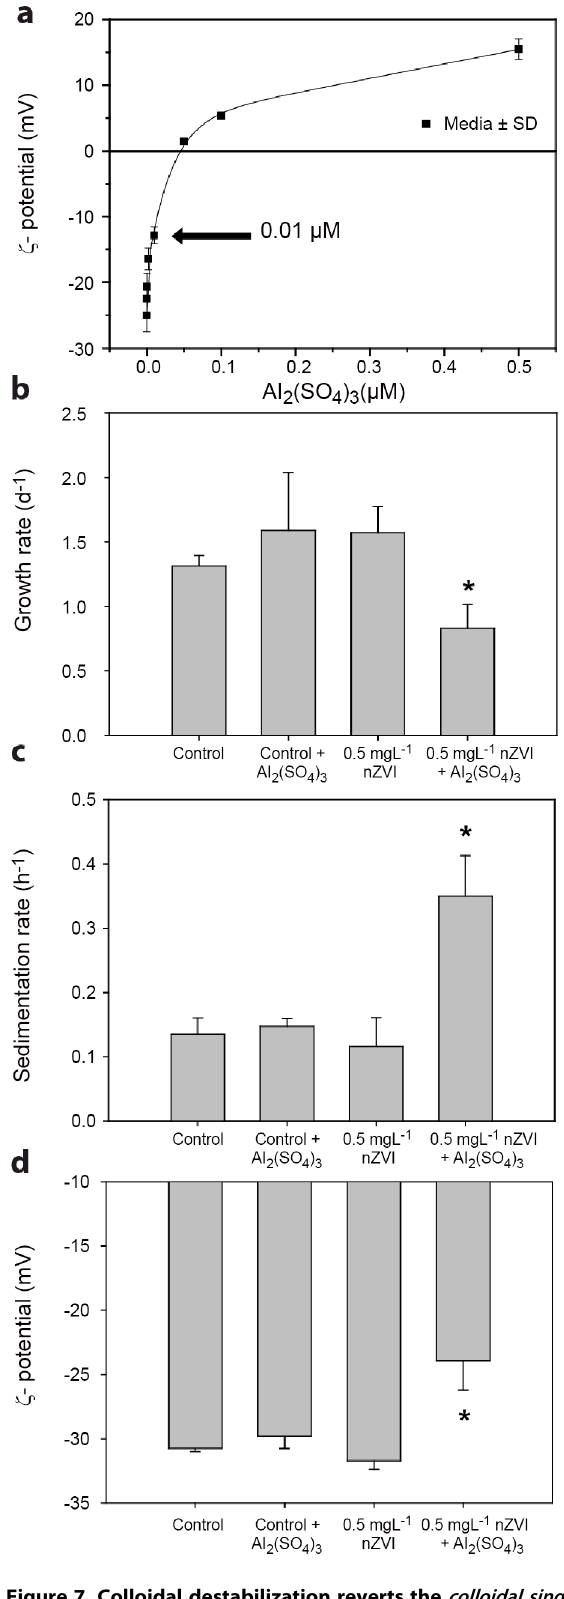
Figure 7. Colloidal destabilization reverts the colloidalsingular- ity and induces nZVI toxicity. (a)Titration curve showing an exponential growth profile. Experimental f -potential of 0.5 mgL 2 1 + nZVI Al 2 (SO 4 ) 3 0.01 m M is marked by an arrow. (b,c,d) Growth